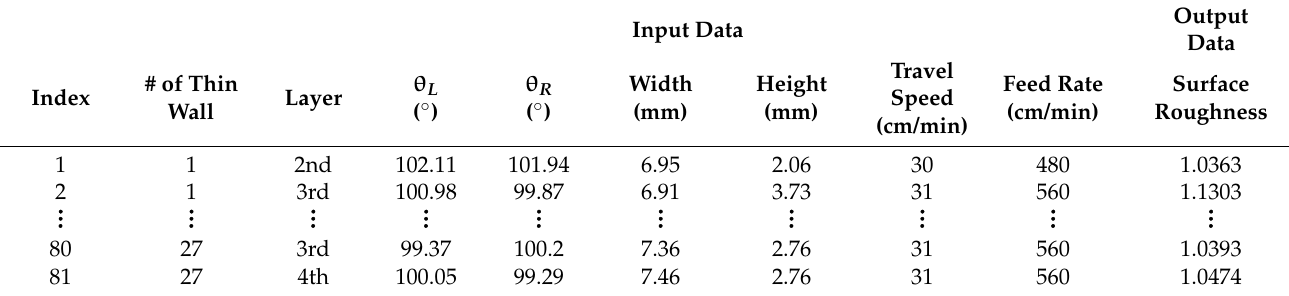
Table 3. Input and output structure. Table 4. Data normalization. Table 4. Data normalization. Table 4. Data normalization. Table 4. Data normalization. Table 4. Data normalization. Table 4. Data normalization. Table 4. Data normalization. Table 4. Data normalization. Table 4. Data normalization. Table 4. Data normalization.